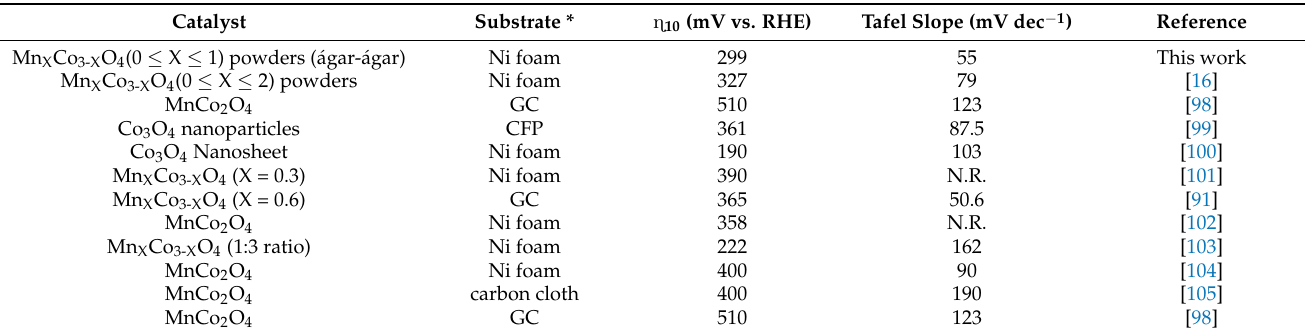
Table 5. Comparison of OER performance of nanostructured Mn X Co 3-X O 4 (0 ≤ X ≤ 1)